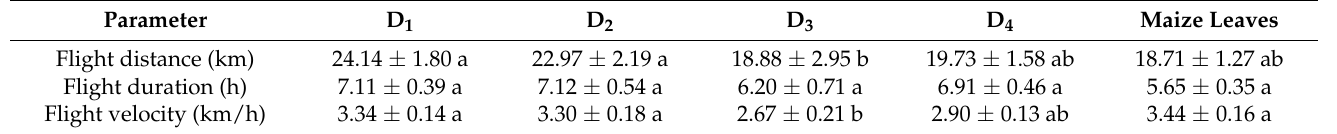
Table 5. Flight performance (mean ± SE) of Spodoptera frugiperda individuals fed different diets, recorded in a laboratory using tethered flight mills. Flight performance is expressed using multiple parameters (i.e., distance, duration, and mean velocity).